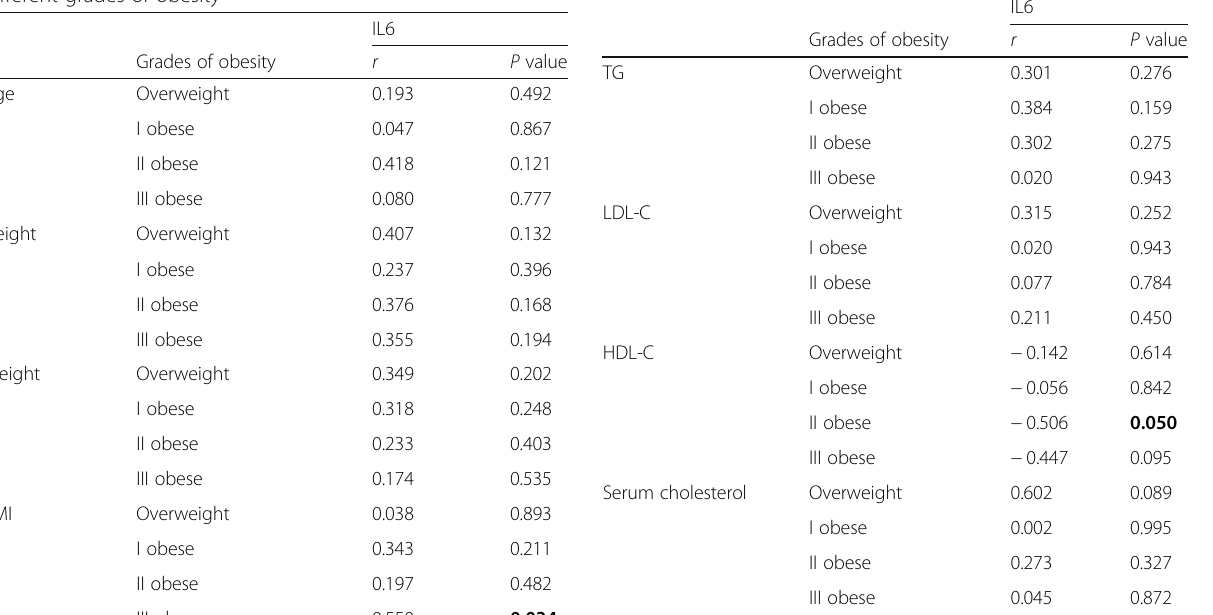
Table 5 Correlation of circulating levels of IL6 to age and anthropometric measures in subjects with overweight and different grades of obesity